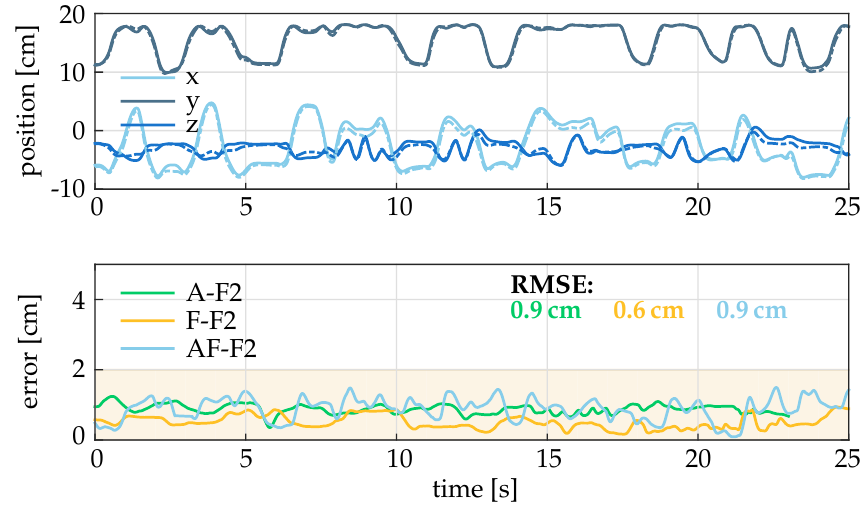
Figure 13. Top: Time series of x-, y-, and z-component of the fingertip position p in the WCS for the combined abduction and flexion motion of the index finger (AF-F2). The solid lines are the calculated position of the hand sensor system with method M1, the dashed lines depict the optical data. Bottom: time series of the tracking error for all three motions of the index finger F2 between the hand sensor system with method M1 and optical system. For better illustration, the signals were low-pass filtered with a cutoff frequency of 2Hz. The error is always below the critical value of 2cm. Abbreviations: A: abduction, F: flexion, AF: abduction and flexion motion, F2: index finger (cf. Table